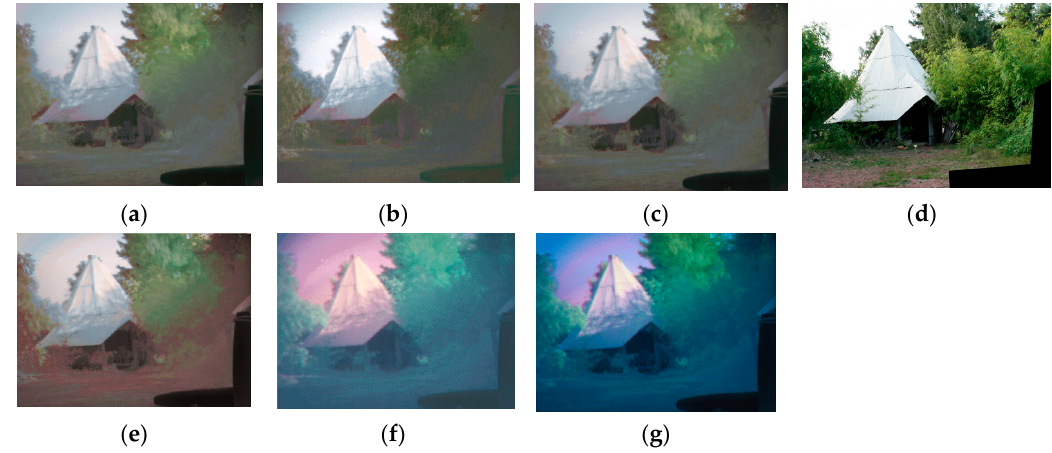
Figure 15. Results from color transformations derived from the standard training set applied to a different environment with different sensor settings: ( a ) CTN method; ( b ) LFF method; ( c ) SHT method; ( d ) daytime reference image; ( e ) CTN2 method; ( f ) SCF method; ( g ) R3DF method.